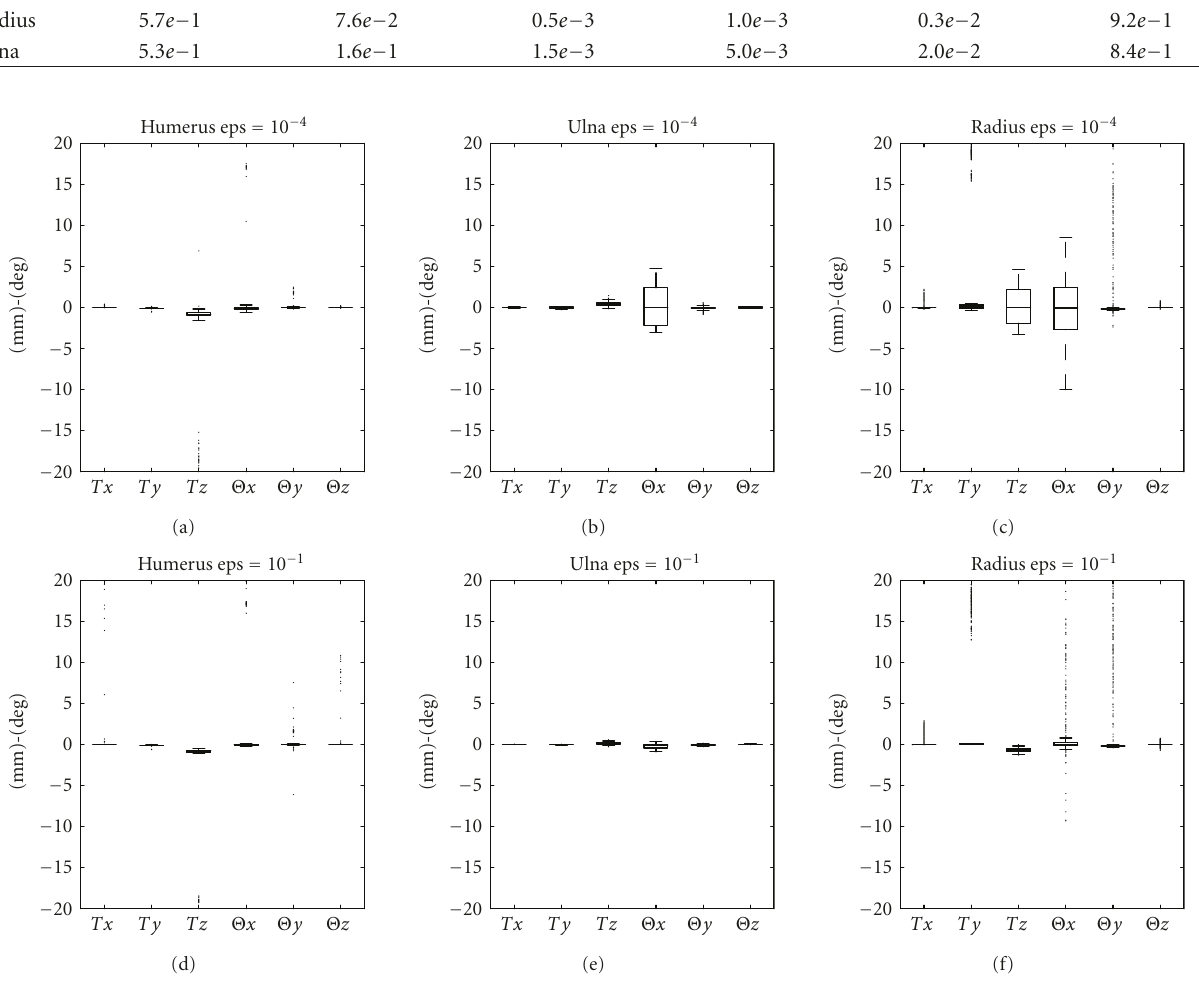
Figure 4: Box and whisker plots of the seq alignment with DMR = 0.5, (panels a, b, c) eps = 10 − 4 mm/deg, or eps = 10 − 1 mm/deg (panels d, e, f).